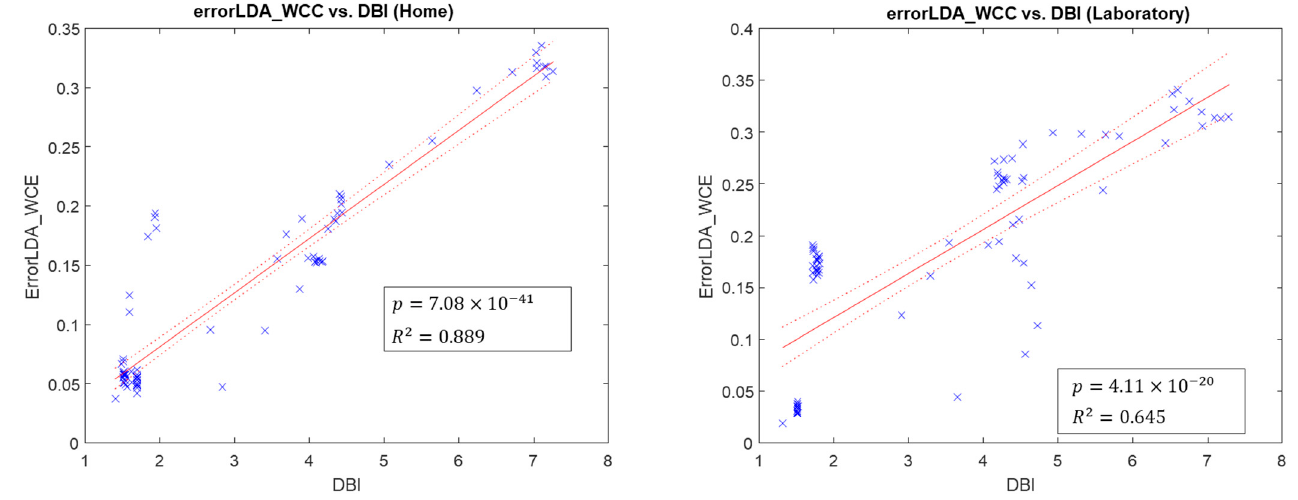
Figure 3. Scatter plots of linear regression fitted models (in red), where WCC error is related to DBI. Each blue x represents a sample result.